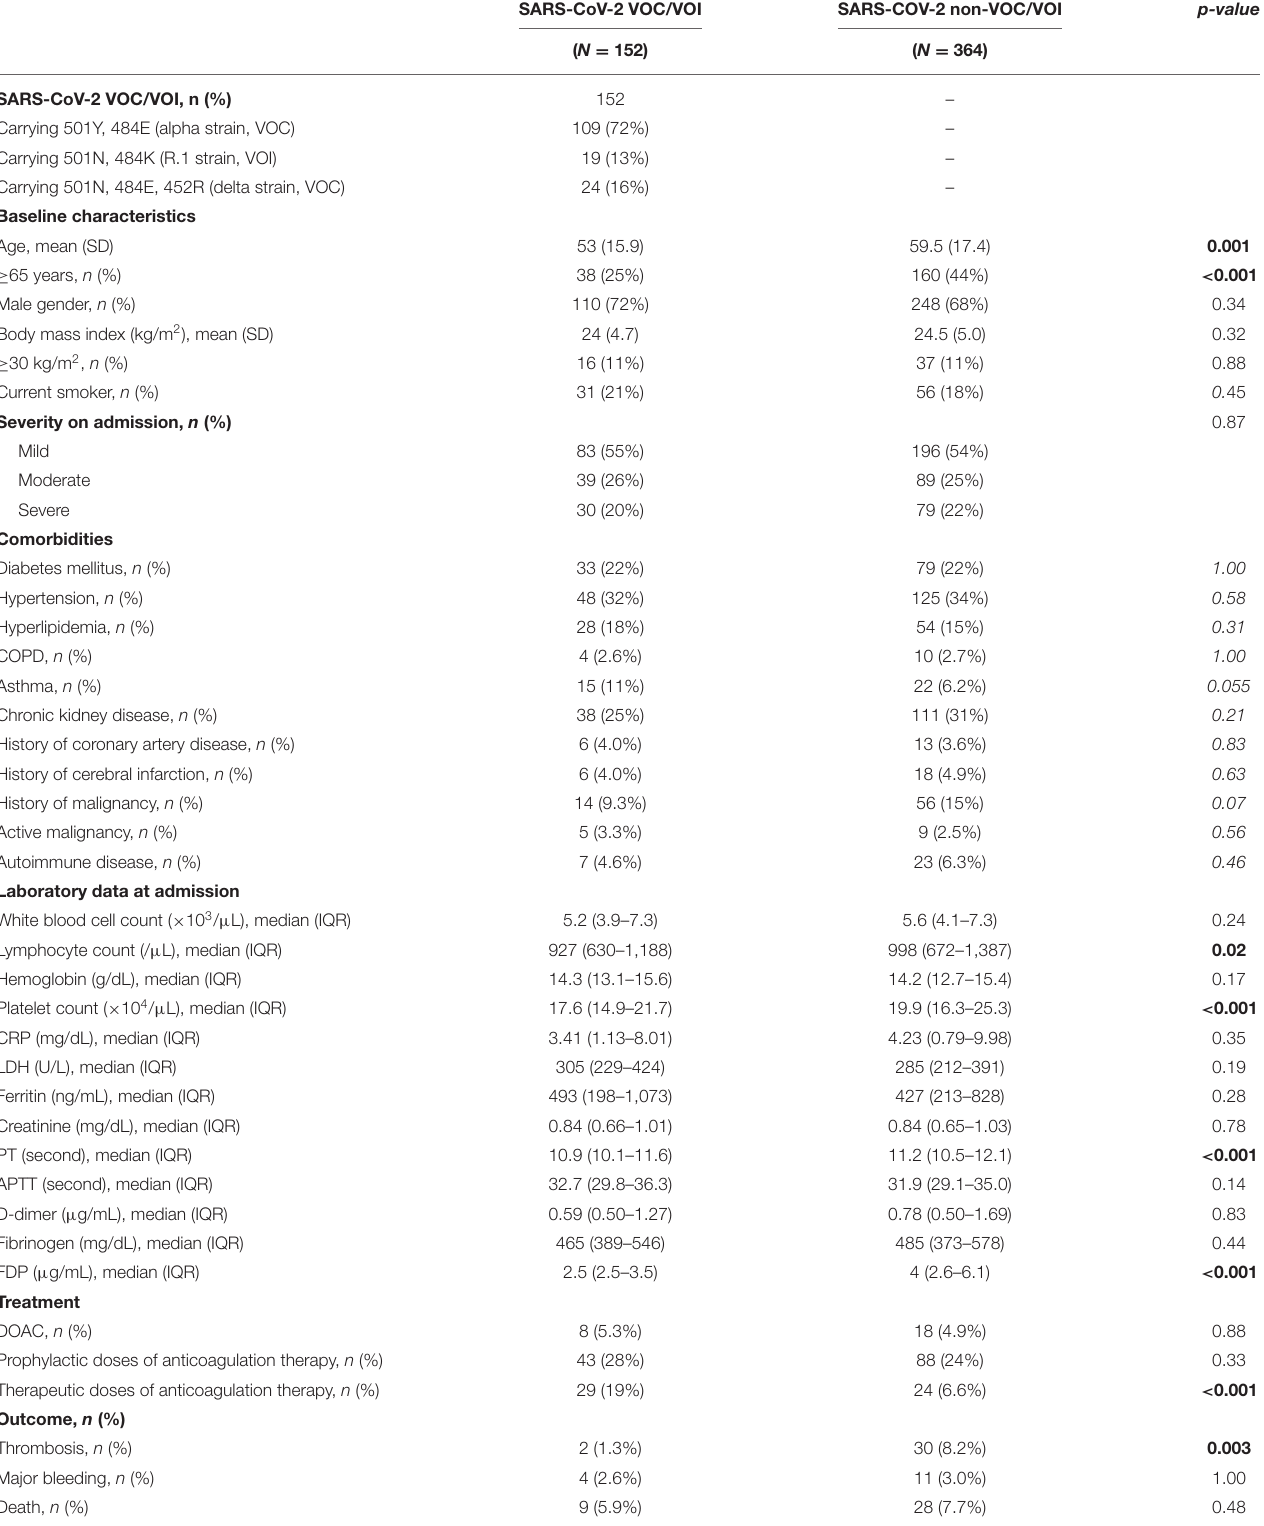
TABLE 5 | Comparison of the clinical characteristics of COVID-19 caused by SARS-CoV-2 VOC/VOI or non-VOC/VOI. SARS-CoV-2 VOC/VOI SARS-COV-2 non-VOC/VOI p-value ( N = 152) ( N = 364) SARS-CoV-2 VOC/VOI, n (%)